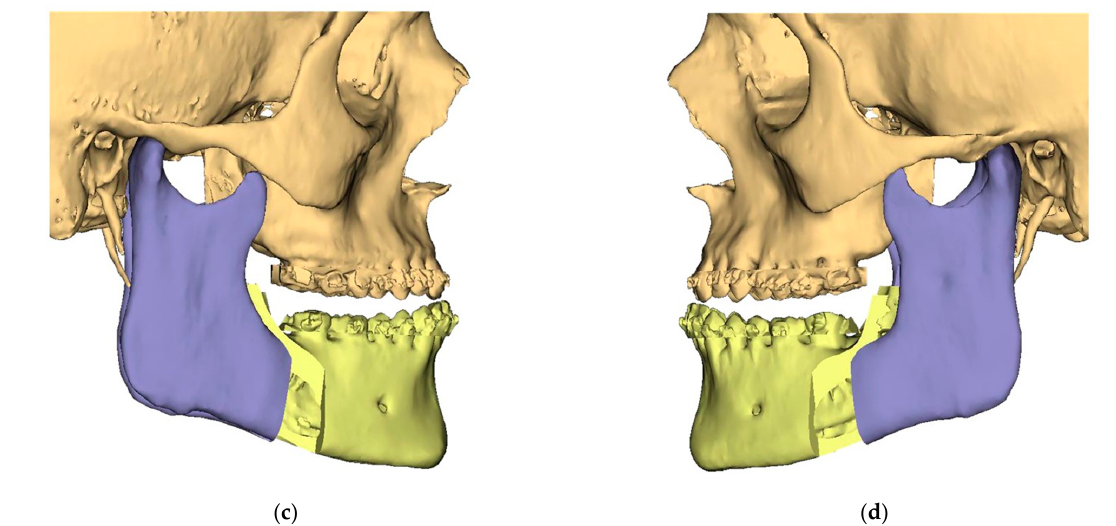
Figure 2. Surgical Plan: Intermediate position showing Mandibular Movement First . ( a ) Frontal view; ( b ) Occlusal view; ( c ) Right side view; ( d ) Left view.